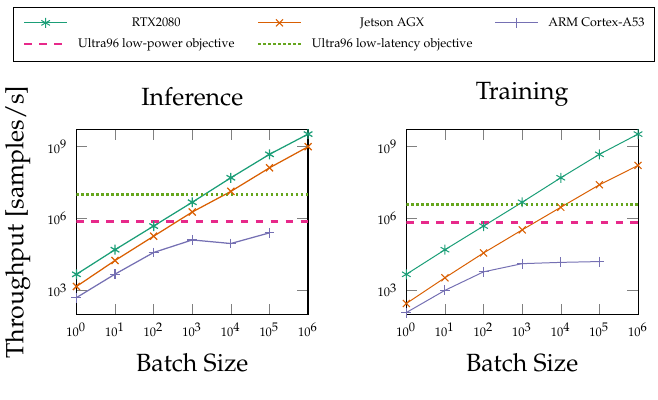
Figure 13. Throughput comparison.